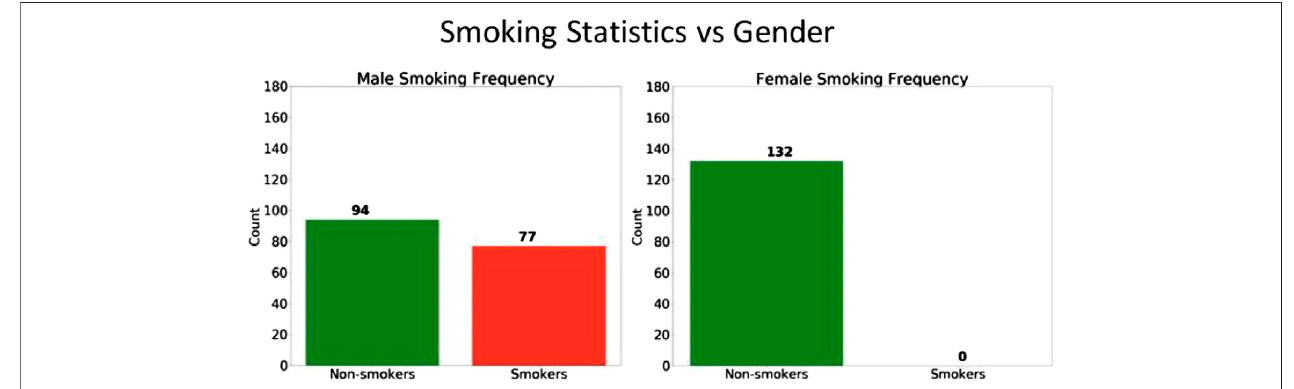
FIGURE 10 | The number of smokers and non-smokers in the each gender